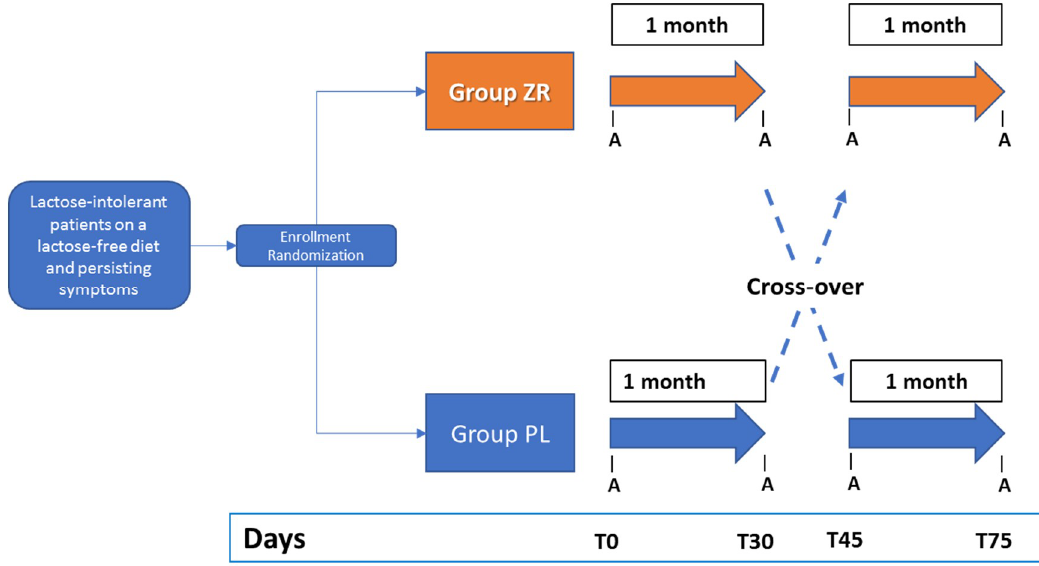
Figure 2. Crossover design of the study and timing of clinical evaluations. During the run-in (Ri) period, subjects fitting the inclusion criteria were randomized to receive either probiotic (ZR: 3 g as packets containing Bifidobacterium longum BB536 four billion CFU, Lactobacillus rhamnosus HN001 one billion CFU with B6 vitamin 1.4 mg) or placebo (PL: similar packets containing maltodextrins, corn starch, silicon dioxide, and no probiotic). The study included a first period of one month of treatment followed by 15 days of wash-out, and a second period of one month of treatment after cross-over. LI—lactose intolerant.